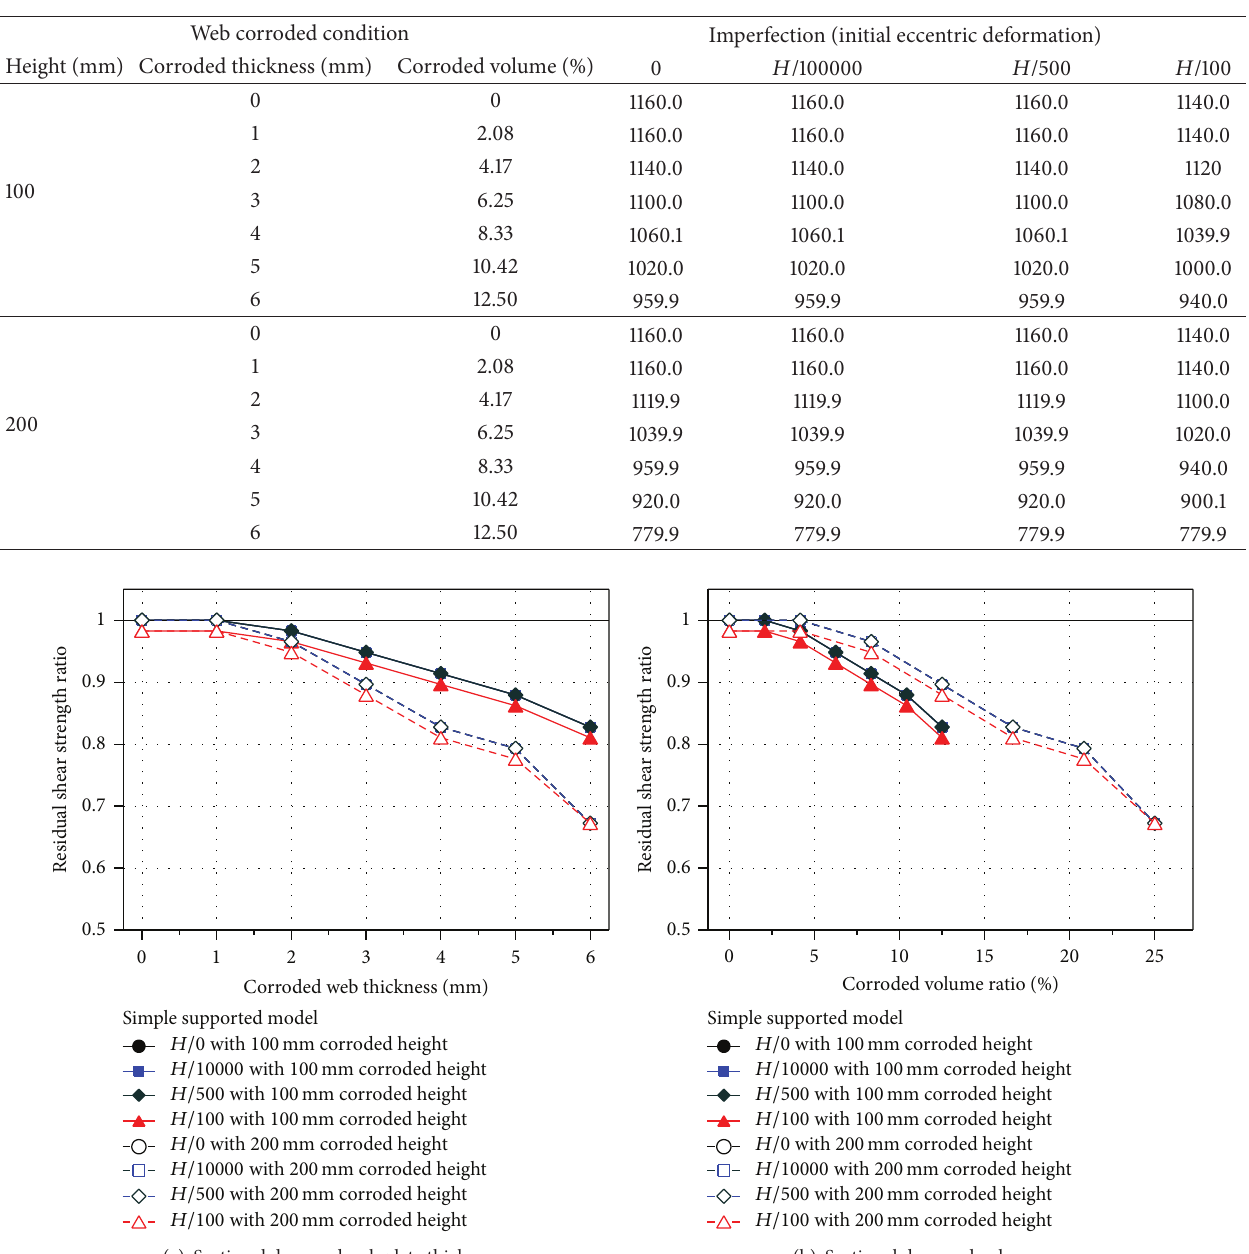
Table 3: Shear buckling resistance of a web plate with imperfection (kN).